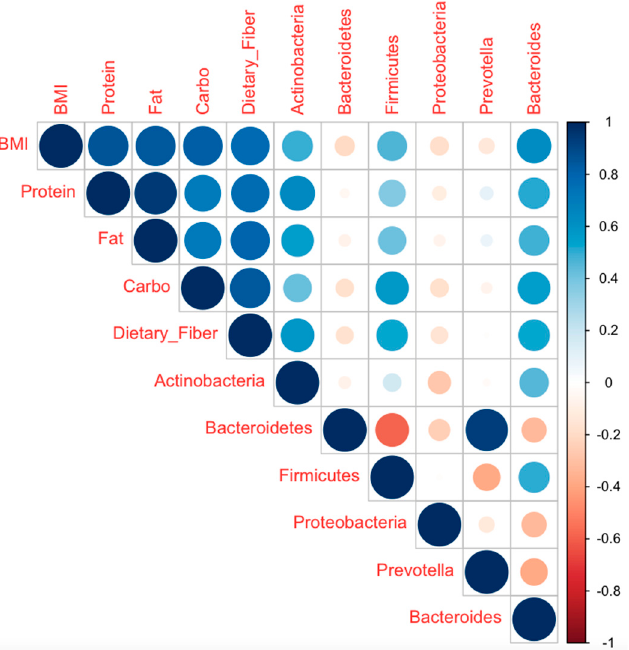
Figure 6. Correlation between diet and gut microbiota composition generated using corrplot. The blue color indicates a positive correlation between two parameters, whereas red indicates that the two parameters are negatively correlated.